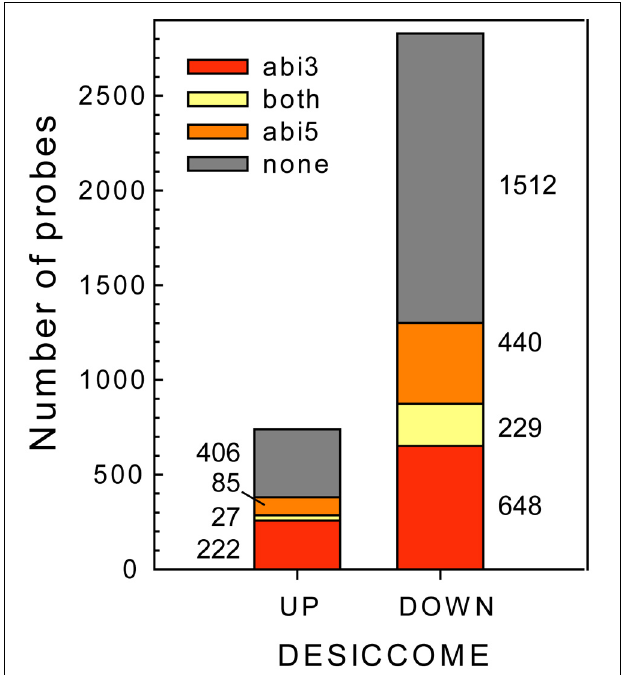
FIGURE 6 | Identification of ABI3- and/or ABI5 related genes in the desiccome (DT-UP and DT-DOWN lists).